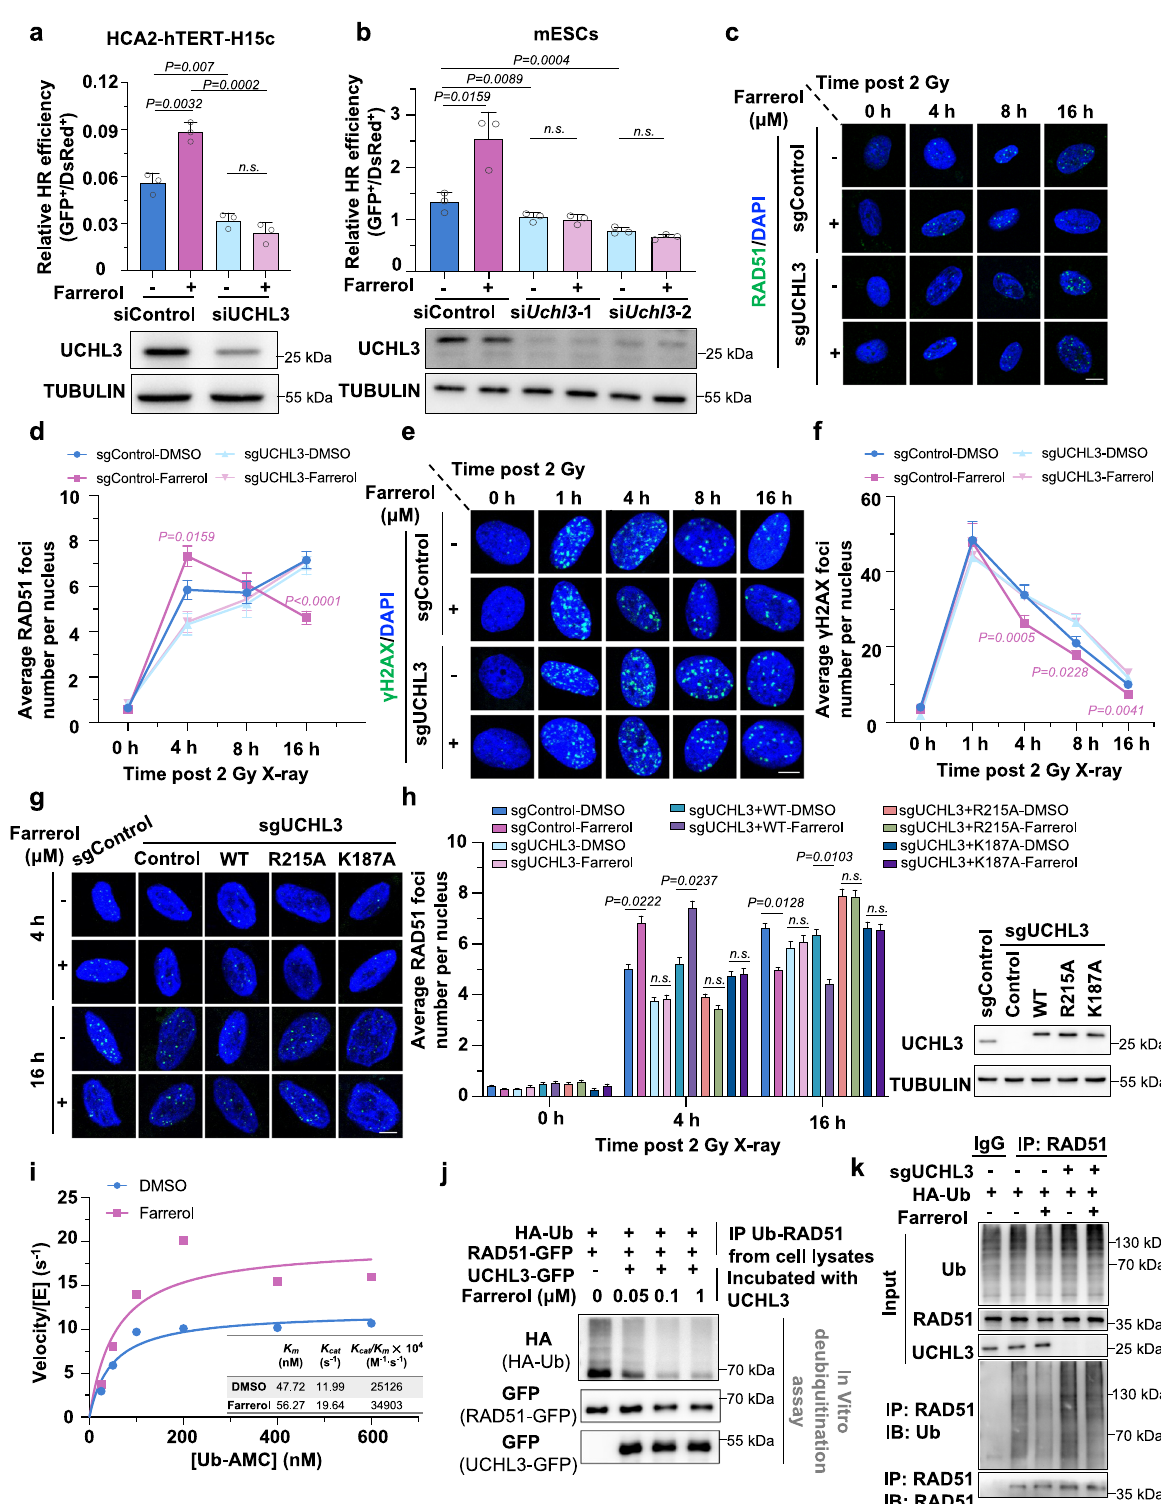
SCNT embryos into pseudopregnant recipient females at the two- cell stage (Fig. 4a). Although only 0.2% of the transferred non- treated SCNT 2-cells developed into full-term E19.5 pups, this proportion was signi fi cantly increased by approximately 10 –